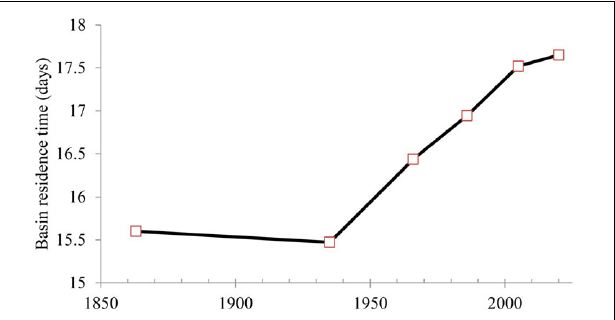
FIGURE 10 | Time series of basin residence time of Jiaozhou